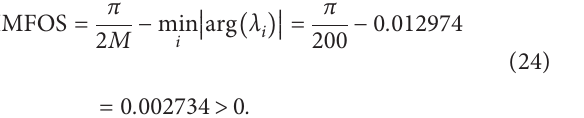
Figure 6: Phase diagrams of system (6) with fractional orders q (b) the x − z phase